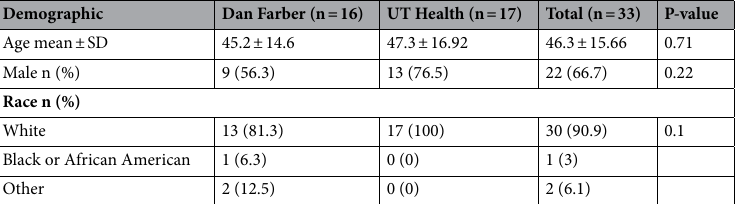
Table 1. The demographic data (age, race, gender) of all patients.